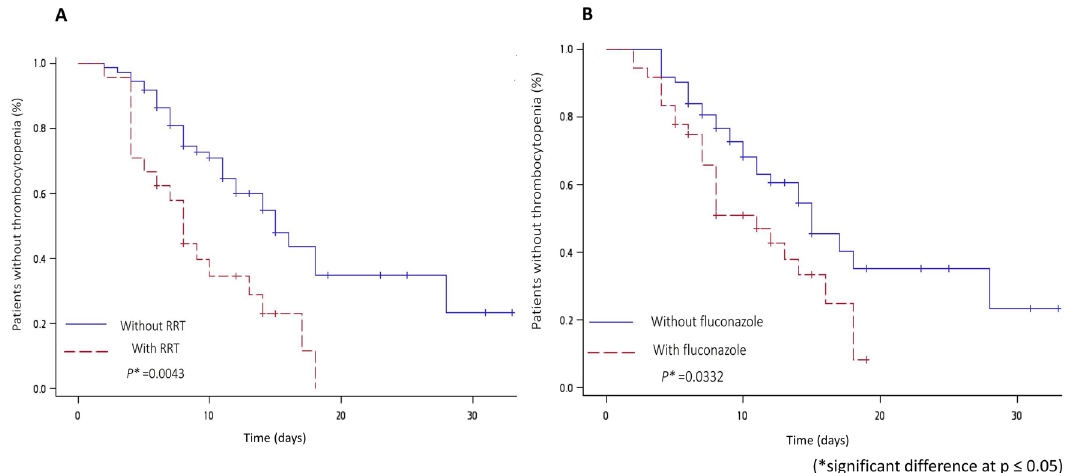
Figure. 2. Kaplan–Meier survival curves to reveal the impact on the incidence of thrombocytopenia. ( A ) Renal replacement therapy (RRT). ( B ) Fluconazole. Difference between groups were tested by log-rank test. Patients who received RRT (log-rank test P = 0.043) or fluconazole treatment (log-rank test P = 0.0332) showed significantly higher risk of developing linezolid-associated